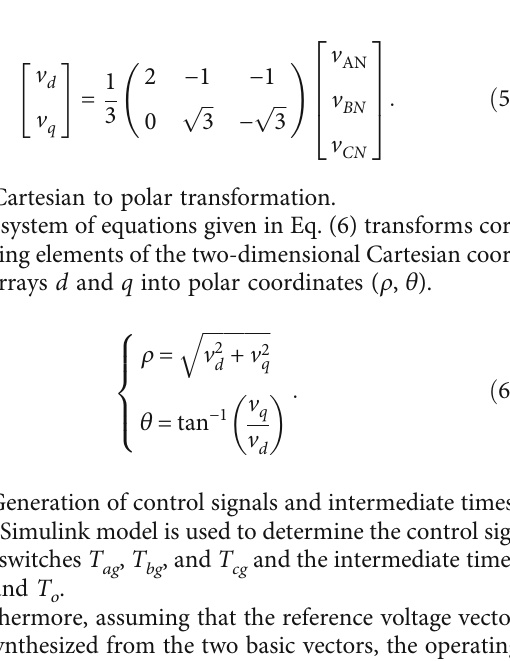
V V an , bn , and cn ) and (b) Currents (